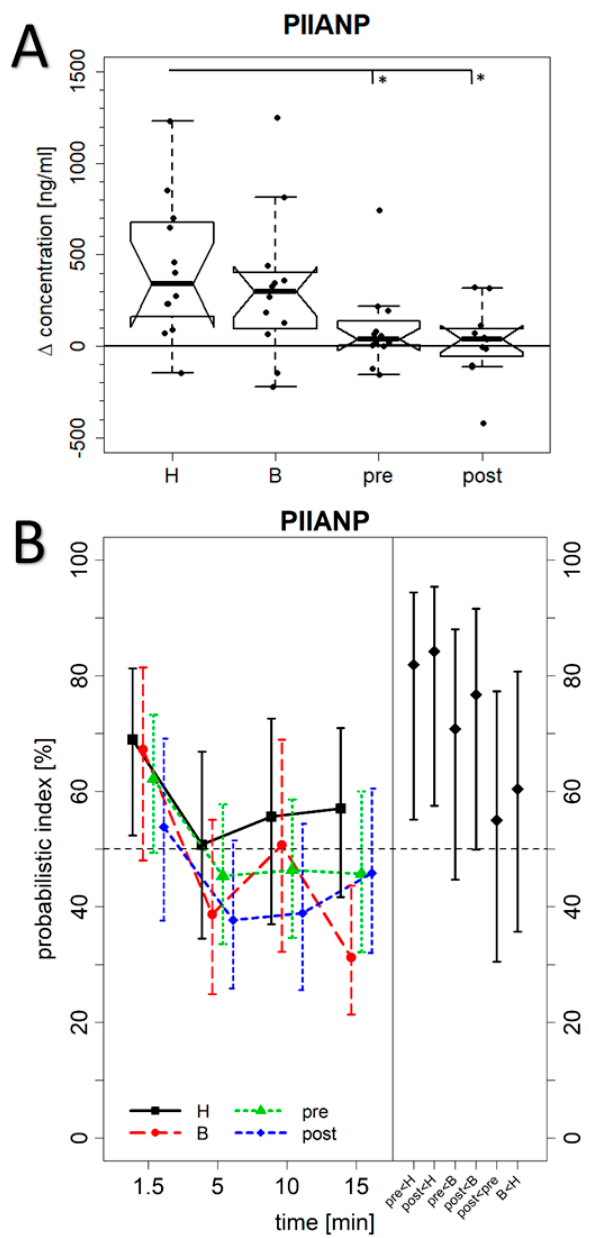
Figure 2. Serum concentration of PIIANP. ( A ) The di ff erence between the maximum biomarker concentrations within the first 15 min after exercising of the hand and finger joints and the PIIANP level at baseline before exercising (H = cohort of patients with more Heberden-accentuated hand OA ( p = 0.0024, n = 12); B = cohort of patients with more Bouchard-accentuated hand OA ( p = 0.012, n = 12); pre = premenopausal control group ( p = 0.09, n = 12); and post = postmenopausal control group ( p = 0.64, n = 12)). Data are presented as notched boxplots with the X-axis at 0 indicating no altered concentration when compared with the time-point before exercising of the hand. The asterisks mark the statistically significant di ff erences. ( B ) The estimated marginal probabilistic indices (PIs) of PIIANP concentrations for each cohort and time point (left, solid symbols connected by polylines of same type and color, augmented by pertaining pointwise 95% confidence intervals as vertical segments) and the estimated summarized PIs for all pairs of cohorts (right, black diamonds, with pairs of cohorts indicated on the horizontal axis) together with their pointwise 95% confidence